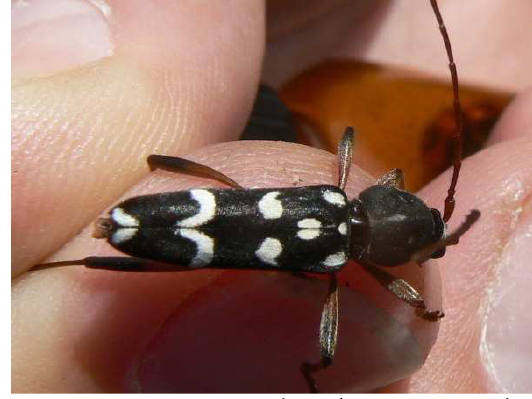
Figure 6. Isotomus speciosus (Schneider, 1787) (photo: Milan Đ uri ć )